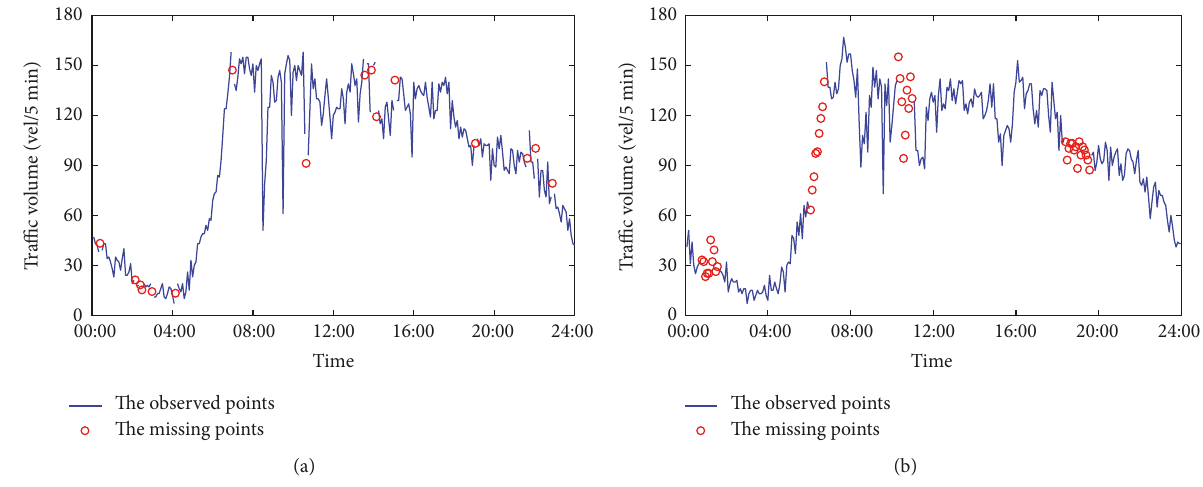
Figure 1: Typical missing patterns of traffic flow data: (a) MCR and (b)